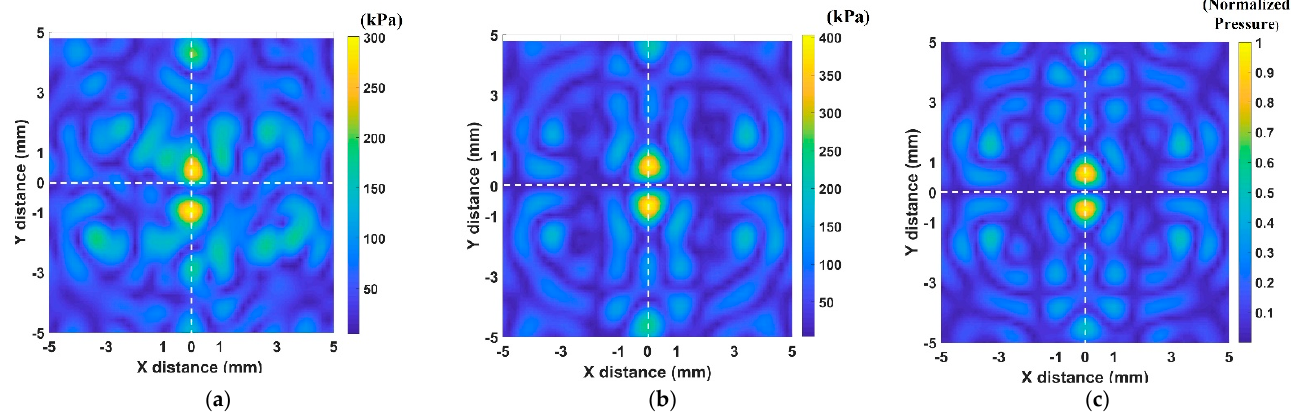
Figure 6. The acoustic pressure field map: ( a ) Scanned acoustic pressure value before calibration; ( b ) Scanned acoustics pressure value after calibration; ( c ) acoustic pressure obtained by simulation.